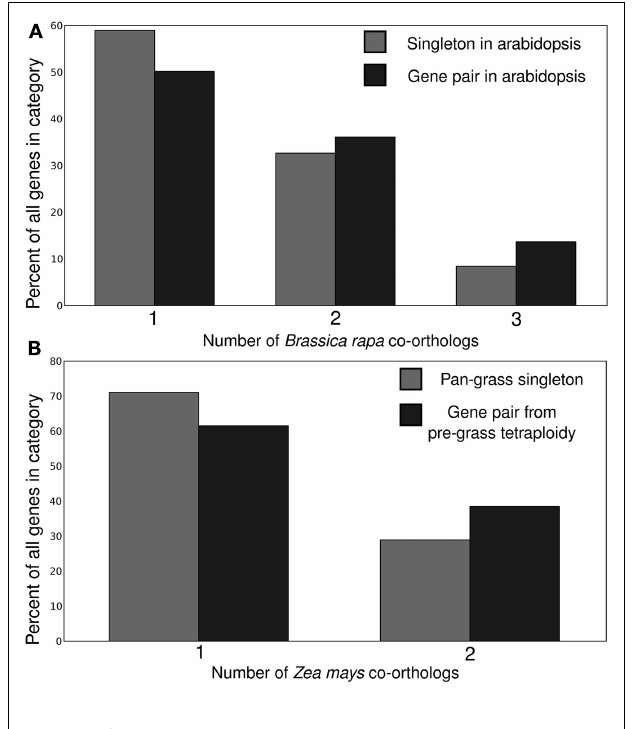
FIGURE 2 | Impact of retention in a previous whole genome duplication on retention in future whole genome duplications. (A) Proportion of Arabidopsis genes with one, two, or three co-orthologs in Brassica rapa. (B) Proportion of genes syntenically retained in sorghum and rice with one, or two co-orthologs in